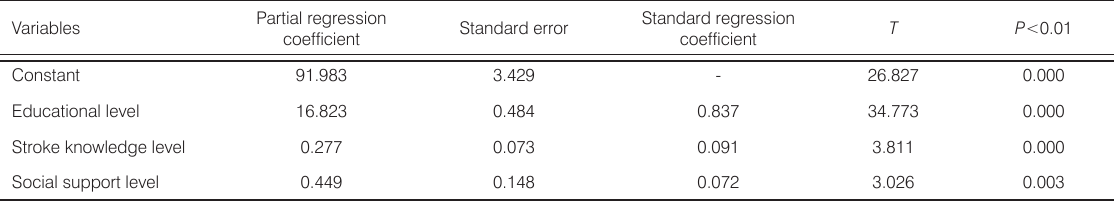
Table 5. Influencing factors of self-management in the stroke recovery stage ( n =440). Note: F =458.631, P =0.000 (<0.001), coefficient of decision R 2 =0.759 and adjusted R 2